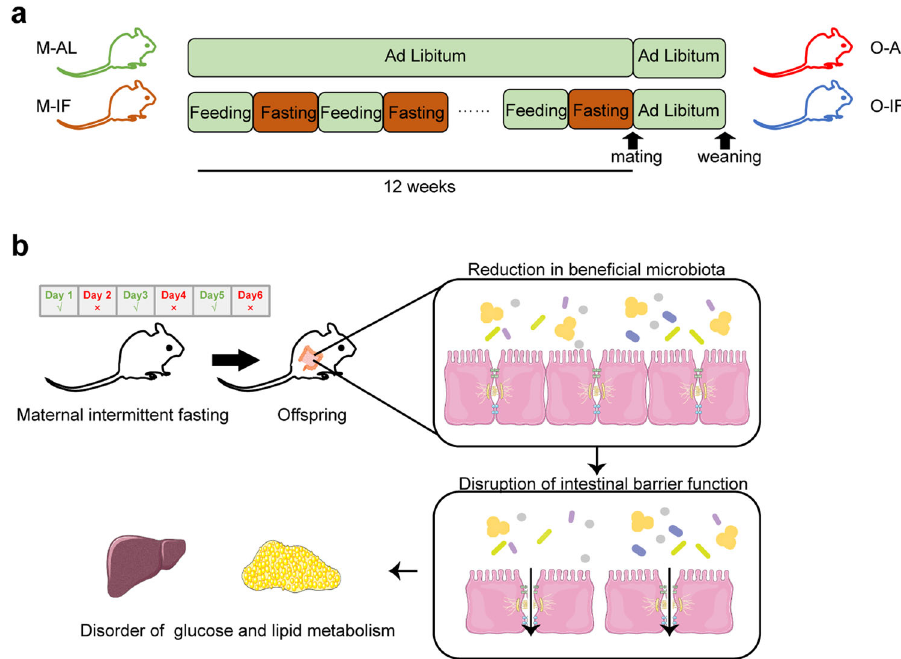
Fig. 7 Graphic highlight of fi ndings. a An experiment scheme of maternal intermittent fasting. b Maternal intermittent fasting reduces bene fi cial microbiota in offspring intestine, leading to disruption of intestinal barrier function of offspring and subsequent disorders of glucose and lipid